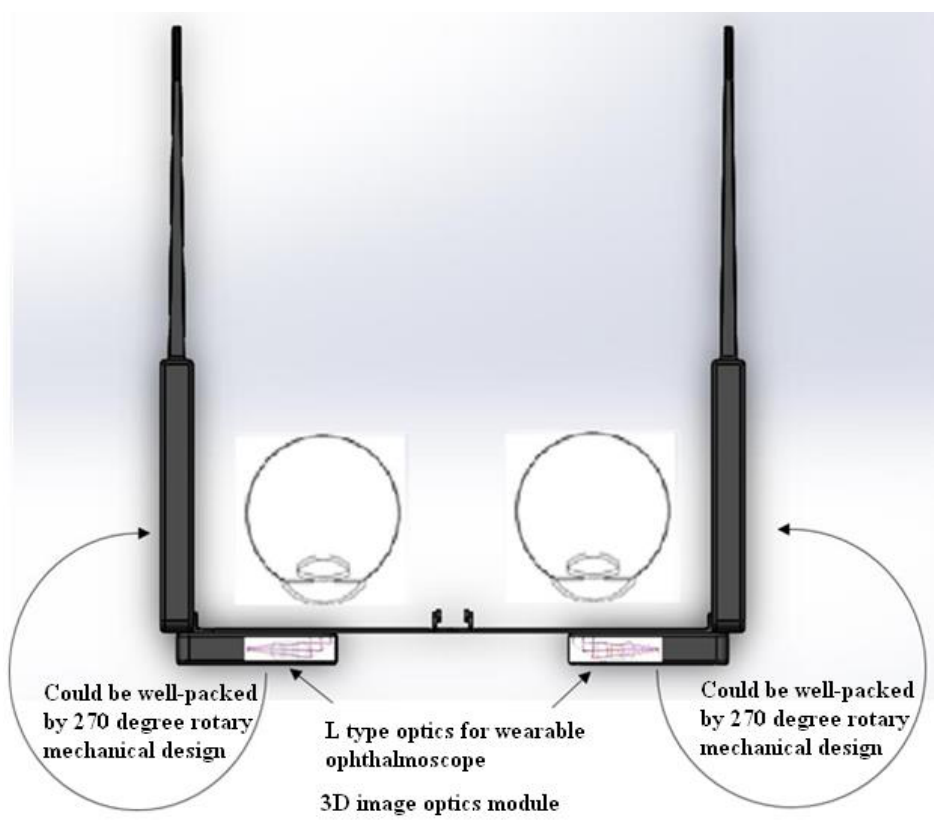
Figure 2. Enclosed concept for the ophthalmoscope lens groups; 3D image-taking modules are rotated 270 degrees and enclosed in the sides of the glasses for use as ordinary glasses.